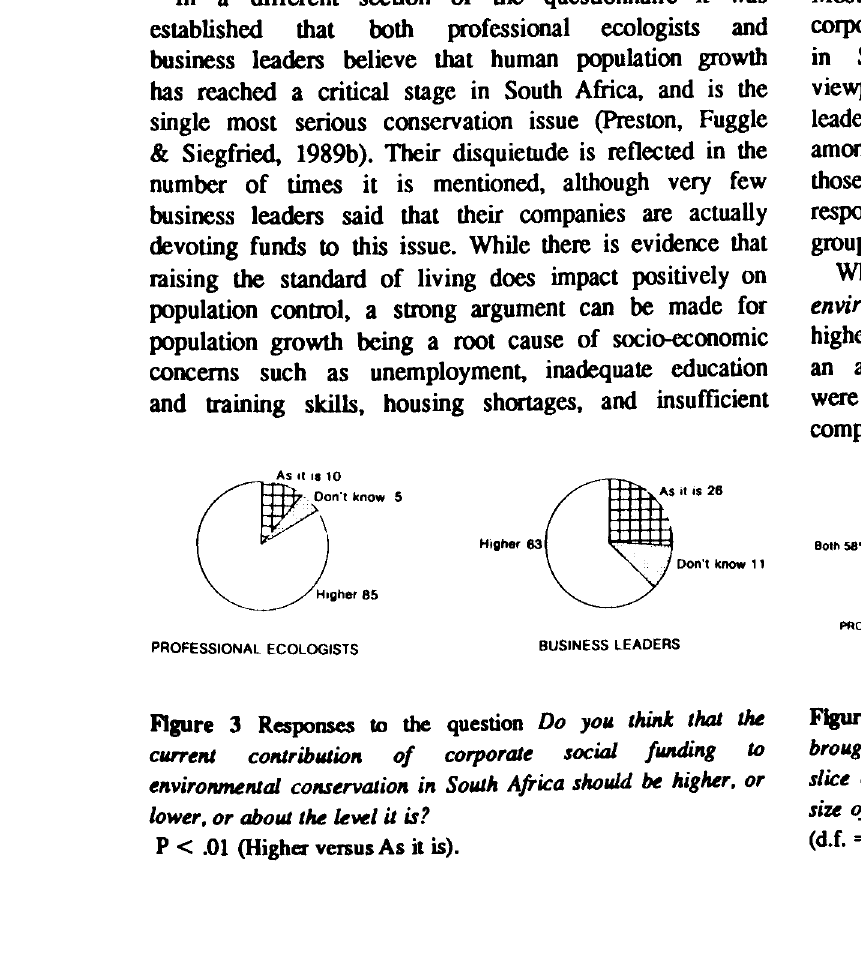
Figure 3 Responses to the question Do you think that the current contribution of corporaJe social f llllding to environmental conservaJion in South Africa should be higher, or lower, or about the level it is? P < .01 (Higher versus As it is).